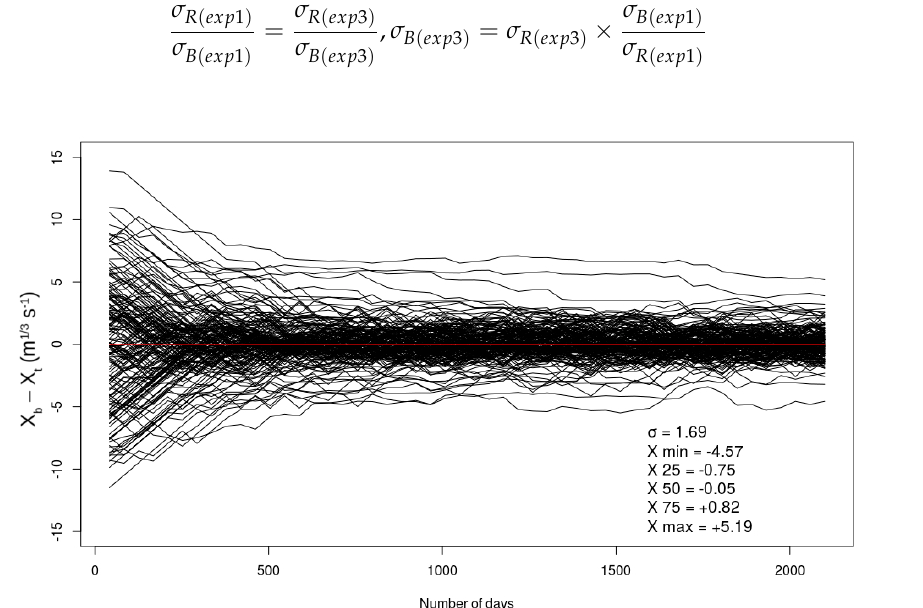
Figure 9. Temporal evolution (1 August 1995 to 15 April 2001) of the difference between the a priori control vector (x b ) and the true control vector (x t ) of the Strickler coefficients in the DA system. The 165 black curves represent the value (x b − x t ) at all 165 reaches defined over the Garonne catchment. The red horizontal line is equivalent to a zero difference between x b and x t . After 5 years (i.e., 50 42 day-assimilation windows), we represent the standard deviation, σ xb , between the 165 values (x b − x t ) in the basin. The X terms represent from top to bottom the minimum value, the 1st quartile, the 2nd quartile, the median, the 3rd quartile, and the maximum value of (x b − x t ) at the end of the experiment (day n° 2100).